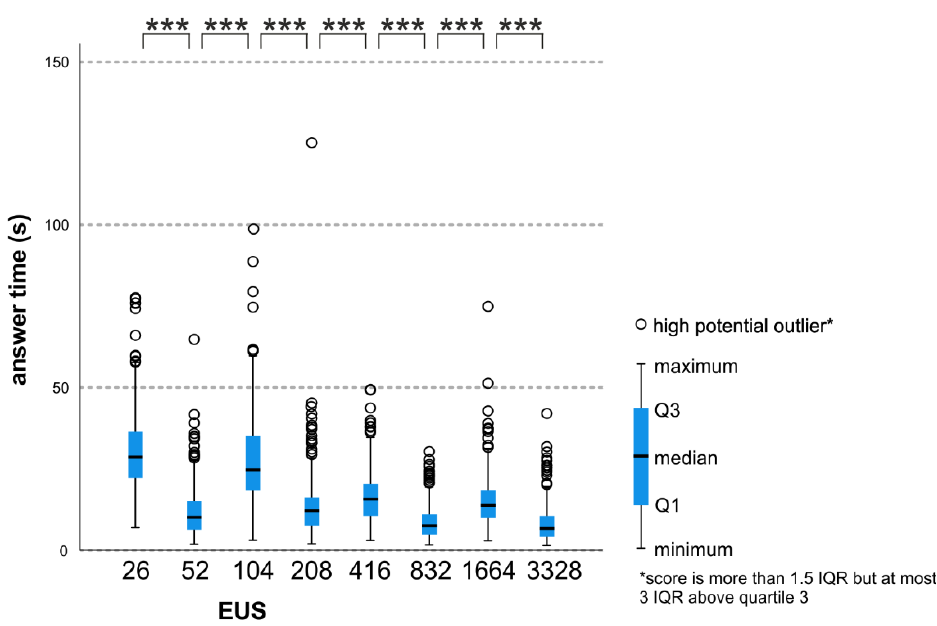
Figure 11. Participants’ answer times concerning T3: Usefulness of the particular enumeration unit sizes, *** p ≤ 0.001.